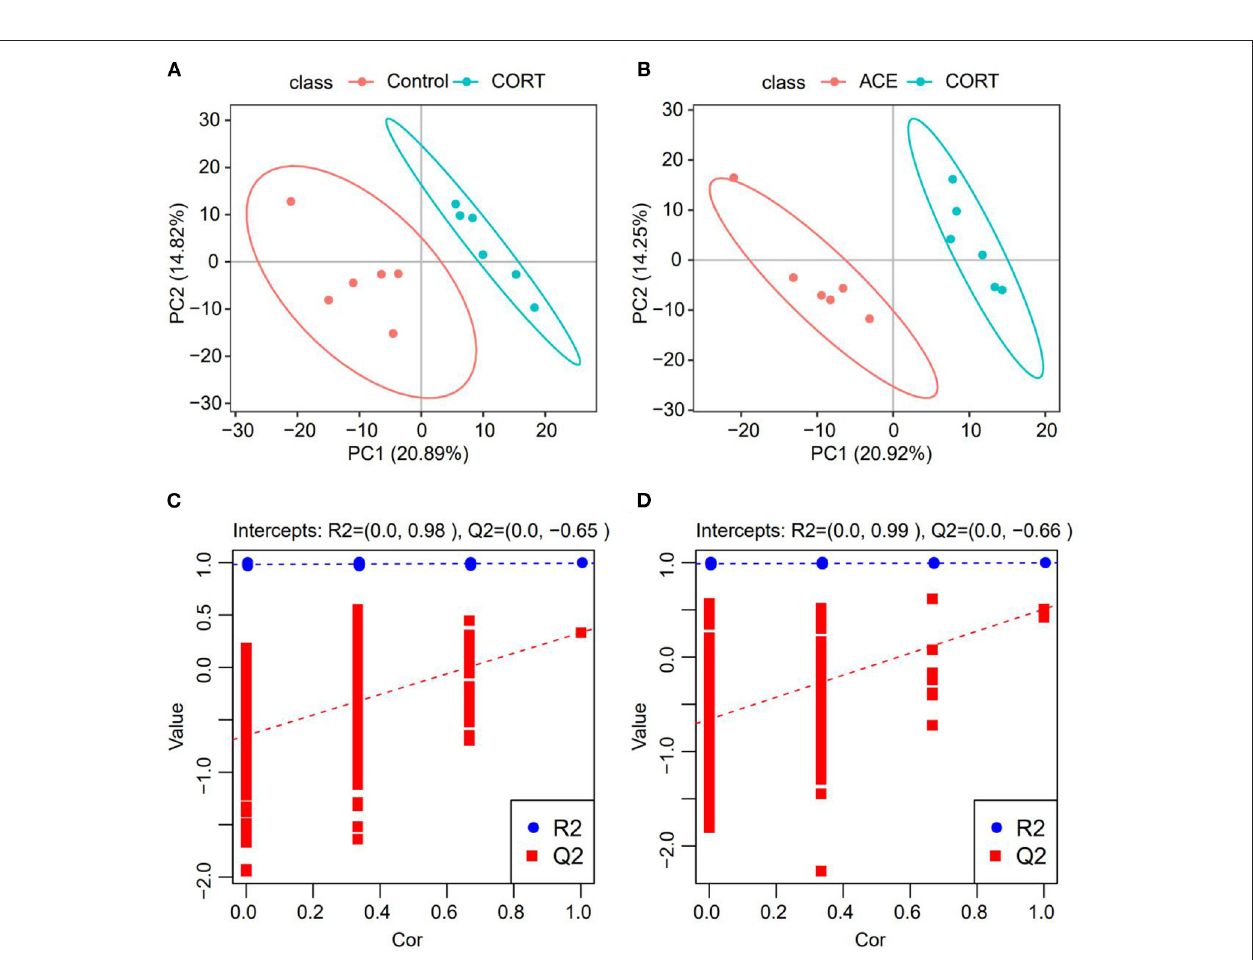
FIGURE 4 | PLS-DA analysis of the samples from the CON, CORT and ACE groups. (A,B) Score graph of the PLS-DA analysis model. The horizontal axis is the first principal component, and the vertical axis is the second principal component. The number in parentheses is the score of the principal component, which represents the percentage of the explanation on overall variance of the specific pricipal component. ( n = 6 per group) (C,D) PLS-DA analysis model response permutation testing graph. The two rightmost points in the figure are the actual R2Y and Q2 values of the model, and the remaining points are the R2Y and Q2 values obtained by randomly arranging the samples used. This result is mainly used to judge whether the model is overfit and the validity of the model ( n = 6 per group).